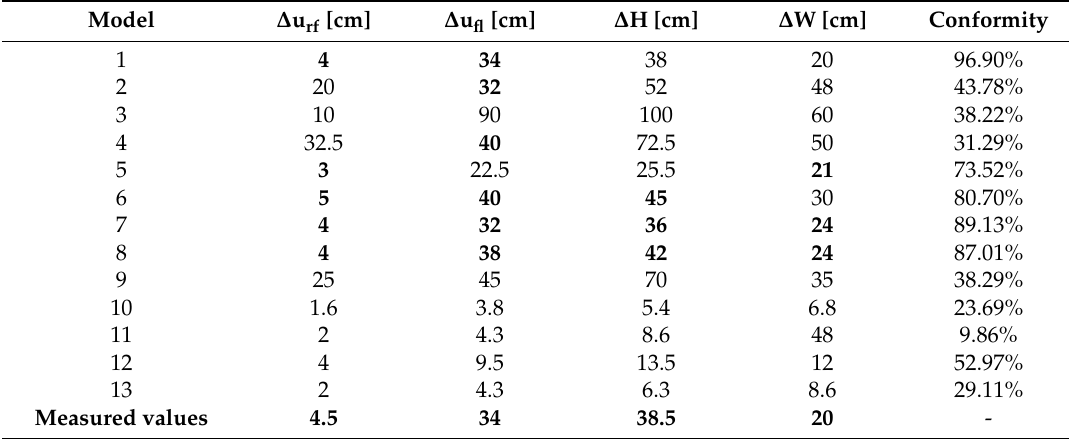
Bold—conformity up to 20% between the value from a model and the measurement.